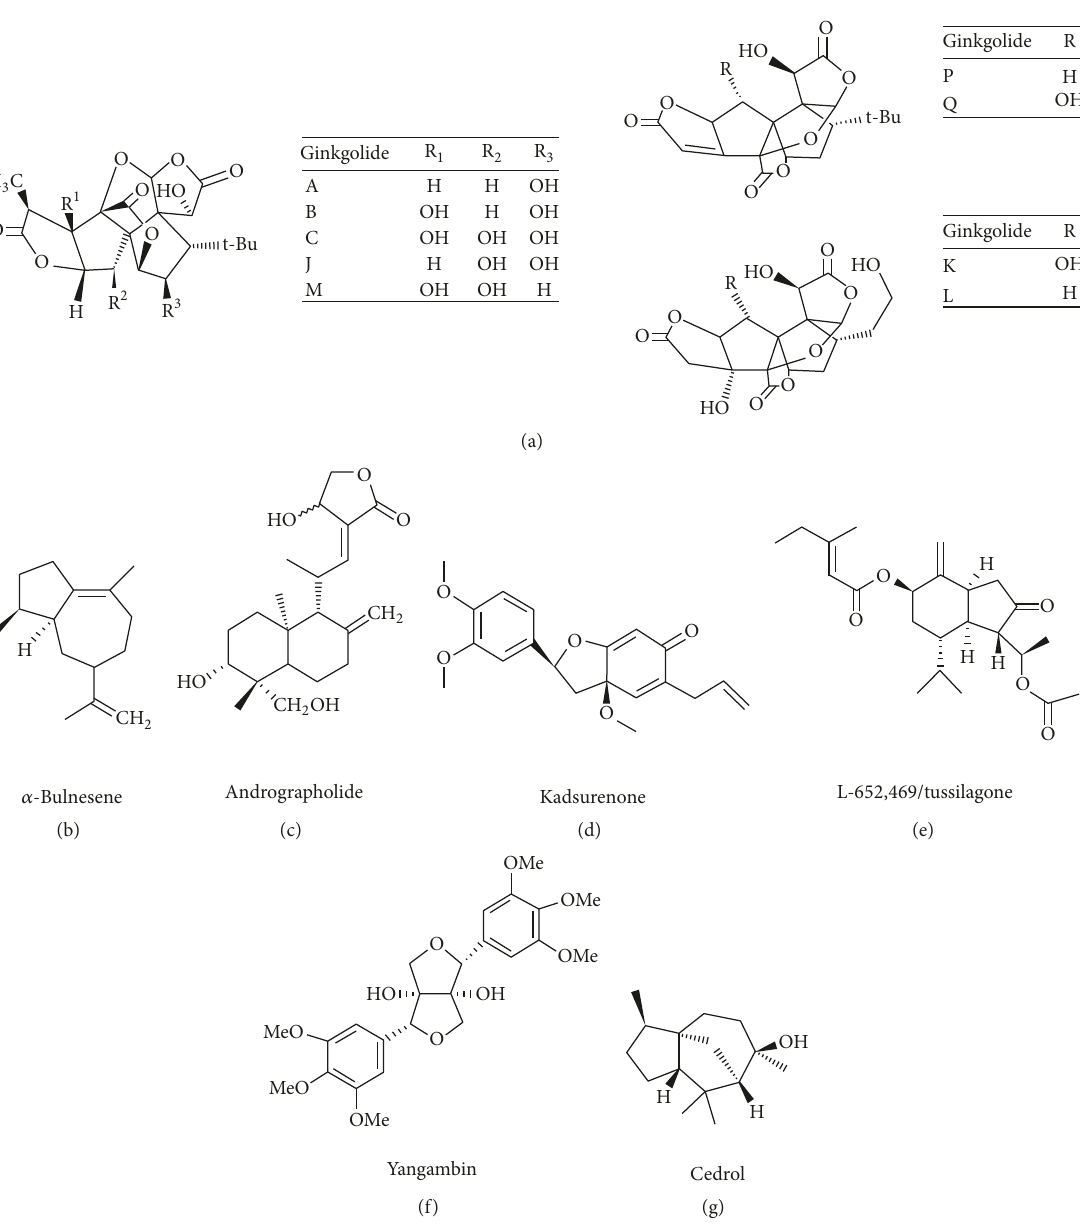
Figure 2: Phytochemical products with anti-PAF